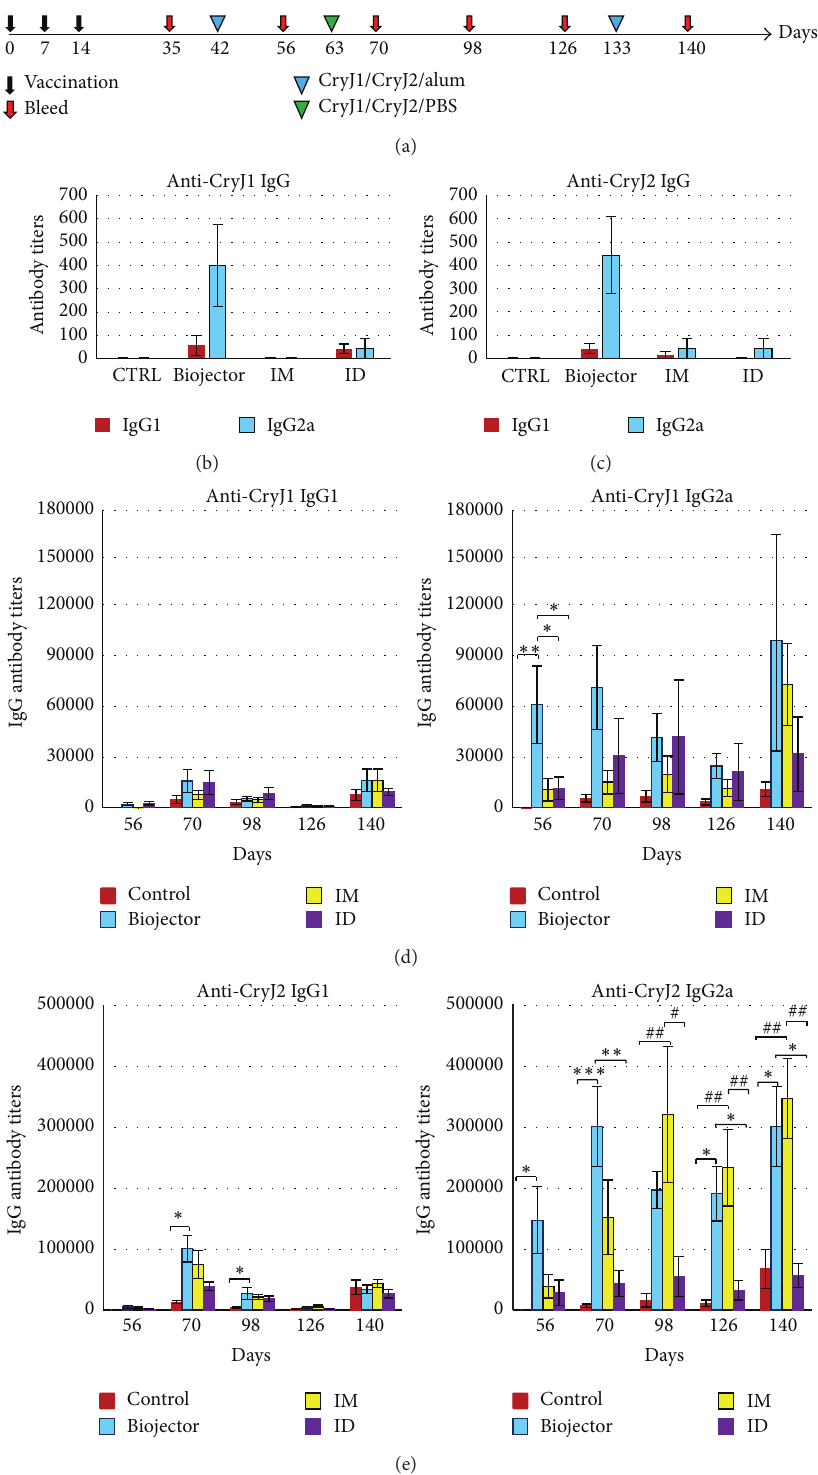
Figure 2: CryJ1-LAMP and CryJ2-LAMP Vaccines induce a robust immune response in vivo . (a) Schematic view of vaccination protocol. Four groups of mice ( 𝑛 = 7 ) were immunized with a mixture of 50 𝜇 g CryJ1-LAMP and 50 𝜇 g CryJ2-LAMP plasmids by intramuscular (IM), intradermal (ID), or needle-free CO 2 pressure Biojector injection. Control vector was delivered by ID injection. Mice were boosted with a mixture of 5 𝜇 g recombinant CryJ1 and 5 𝜇 g CryJ2 in the presence of alum adjuvant as indicated. Mice were bled as indicated. Anti-CryJ1 (b) and anti-CryJ2 (c) IgG1 and IgG2a antibodies after three DNA injections were tested on day 35 by endpoint ELISA method. Anti-CryJ1 (d) and anti-CryJ2 (e) IgG1 and IgG2a antibodies after protein boosts were assessed and summarized. This is a representative of two similar studies. All data are shown as mean ± SEM. Comparisons between Biojector and control, IM, or ID, ∗ 𝑝 < 0.05 , ∗∗ 𝑝 < 0.01 , and ∗∗∗ 𝑝 < 0.001 ; comparisons between IM and control or ID, # 𝑝 < 0.05 and ## 𝑝 < 0.01